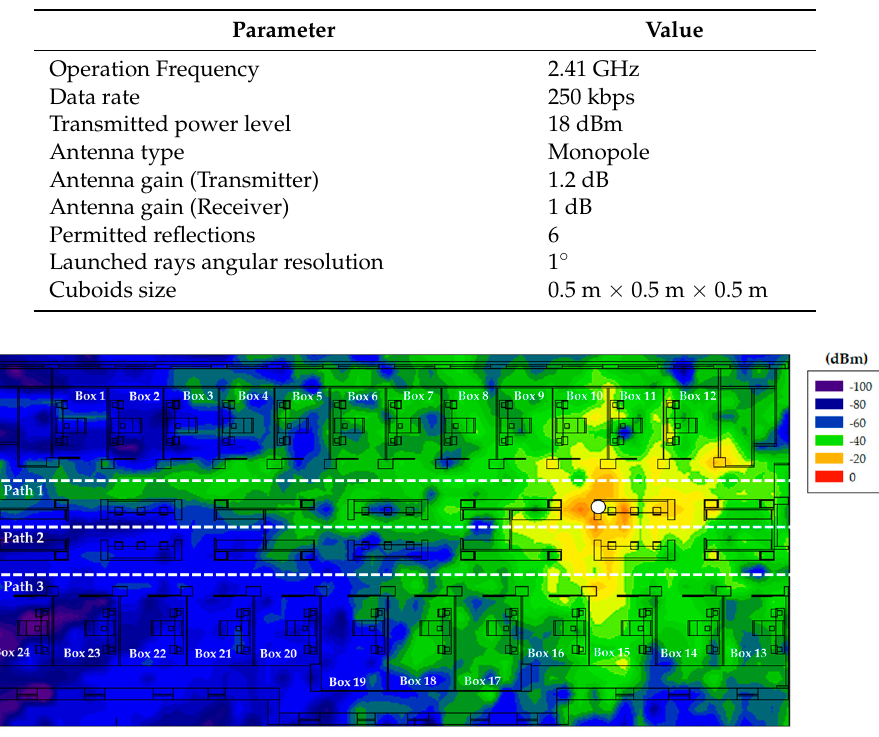
Table 3. 3D Ray Launching parameters.